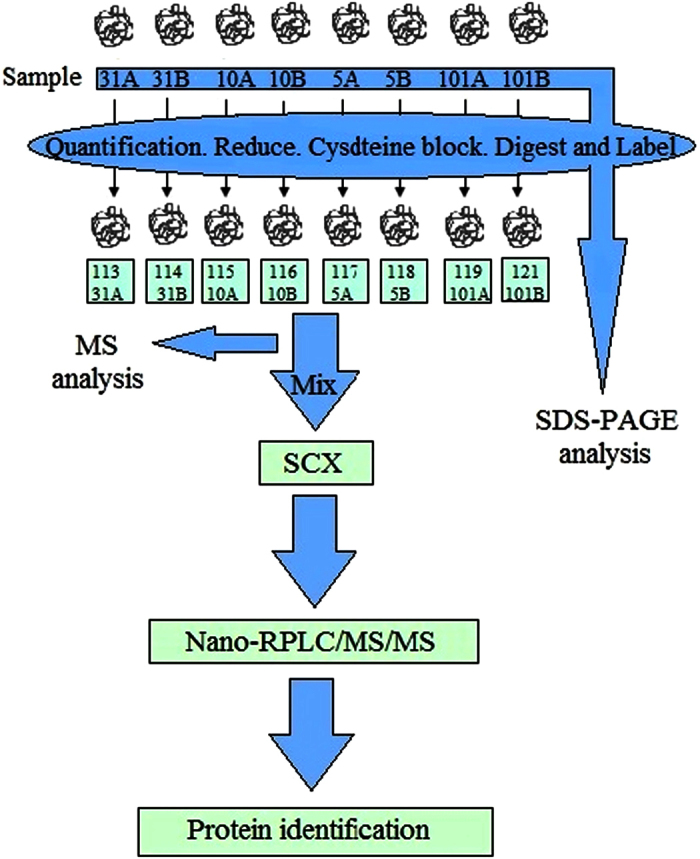
Summary of iTRAQ procedure.The extracted proteins from 4 pairs of stage III/IV gastric cancer were treated with reducing and cysteine blocking reagents. After digestion by trypsin, the peptides were labeled with iTRAQ reagents. The labeled peptides were then mixed and purified by strong cation-exchange (SCX) chromatography. The purified peptides were analyzed by LC-MS/MS for both identification and quantification. Data was analyzed by Protein Pilot Software v. 5.0 (AB SCIEX).